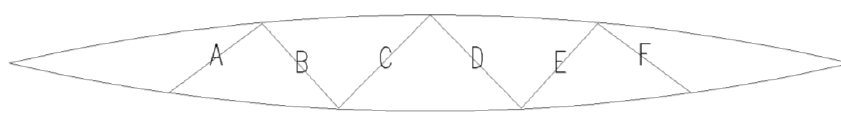
Fig. 32 Letters assigned to the diagonals for reading